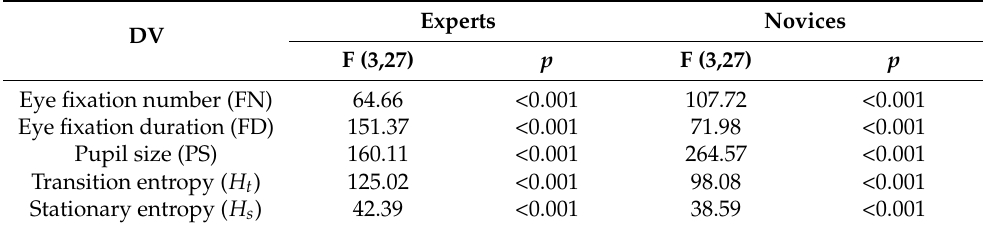
Table 5. Results of the one-way repeated measures analysis of variance on eye movements